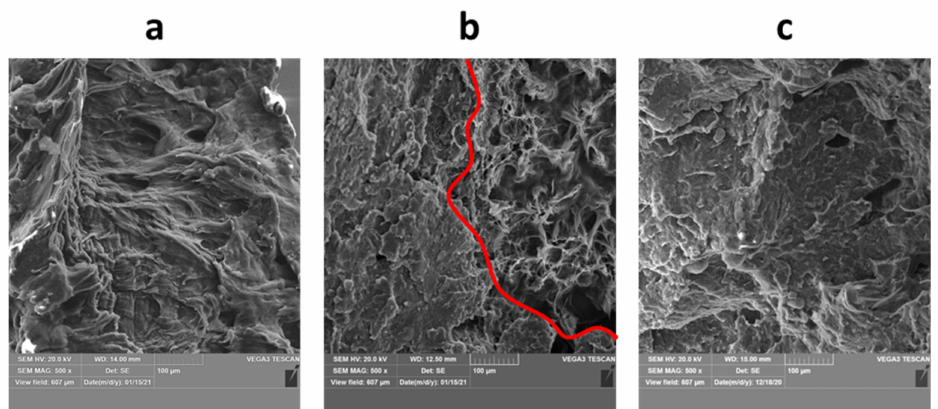
Figure 21. The fracture modes observed for prints with different thickness: ( a ) 1 mm (sample 1.1), ( b ) 2 mm (sample 1.2) and ( c ) 3 mm (sample 1.3).